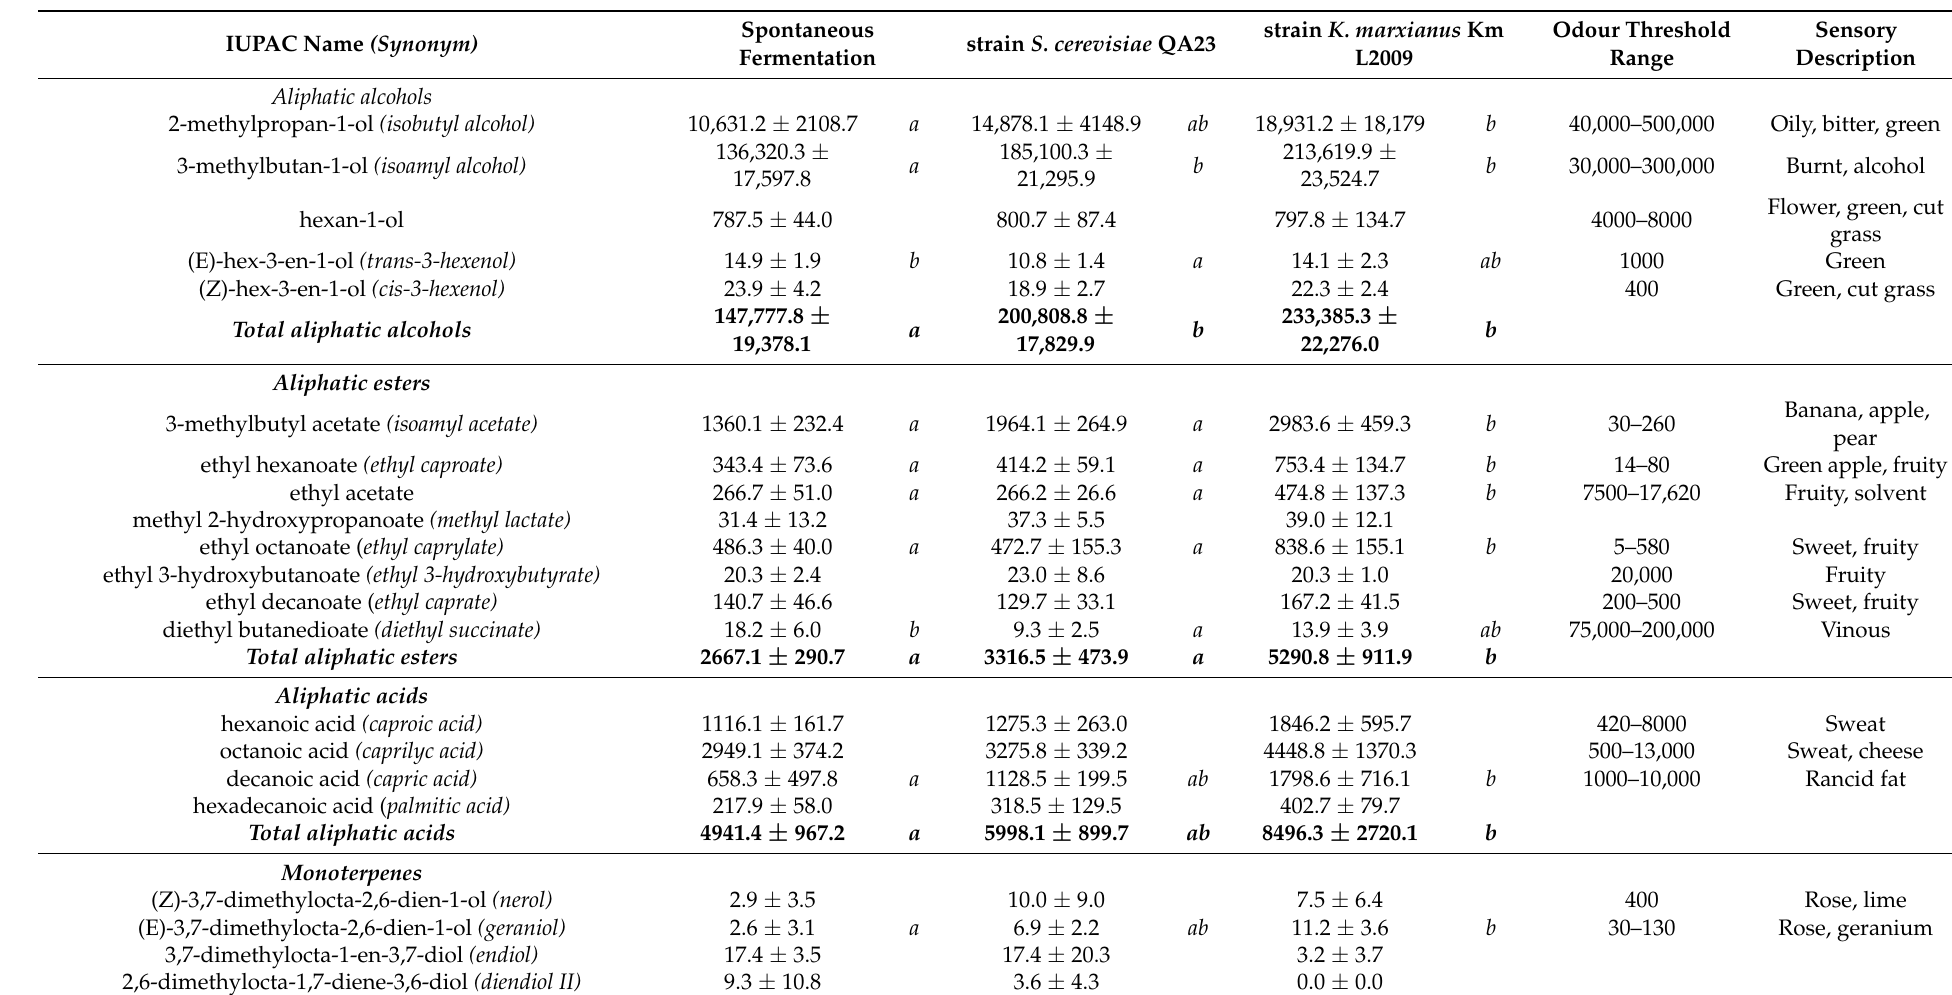
Table 5. Free volatile compounds (in µ g/L) found in Grillo wines. Odor thresholds and sensory descriptions according to